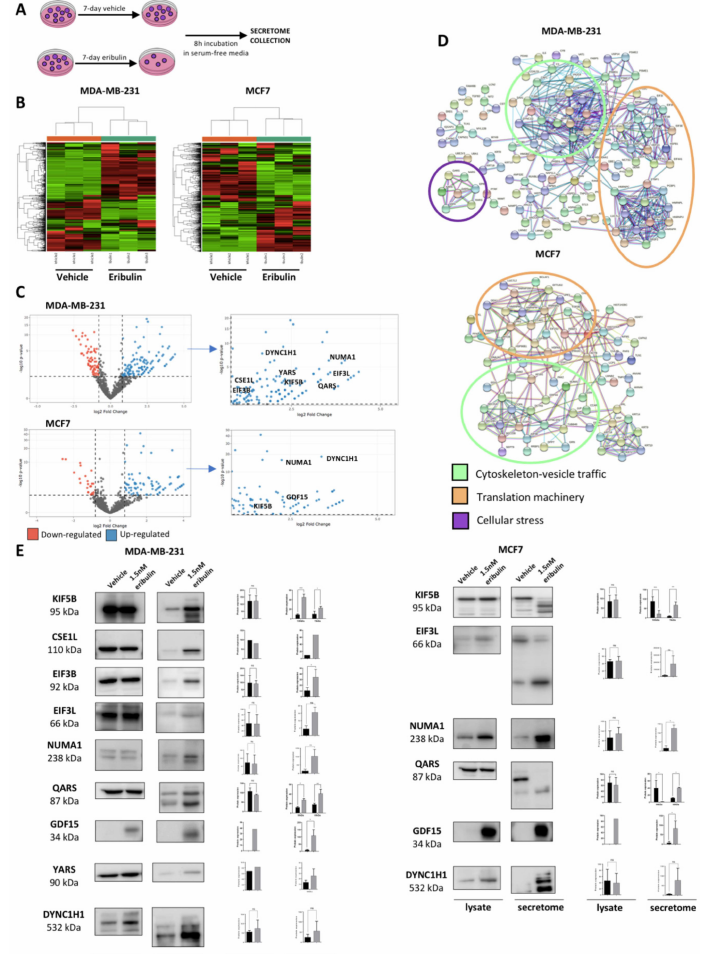
Figure 2. The secretome profiling of DTP cells reveals an over-secretion of a specific subfamily of biomarkers. ( A ) Schematic representation of secretome collection after a vehicle and eribulin treatment. ( B ) Heat maps representing the proteins that were significantly over-and/or down secreted, when MDA-MB-231 and MCF7 cells were treated for 7 days with vehicle or IC80 eribulin (representative heat maps of one out of three biological replicates showed in Supplemental data). Columns represent samples (per group); rows are m/z peaks (not in numerical order). ( C ) Volcano plots of the up-regulated (blue) and down-regulated (red) proteins after 7-day IC80 eribulin treatment. For each plot, the x -axis represents the log two-fold change (FC), and the y -axis represents -log 10 p -value. To identify statistically significant differentially secreted proteins, a Poisson statistical test was used to model our spectral count dataset. Adjusted p -value < 0.05, fold change > 0.8 and number spectral counts (SpC) > 4 thresholds were applied during the analysis. Enlargement of the up-regulated protein panel in the Volcano plot shows the eribulin induced secreted candidate biomarkers according to the protein subfamilies resulting from the STRING analysis (right panel). ( D ) STRING Network Analysis of over-secreted proteins after 7-day IC80 eribulin treatment showed two specific interaction nodes related to cytoskeleton-vesicle trafficking (green) and translation machinery (orange) protein subfamily. ( E ) Cell lysates (10 µ g) and secretome (10 µ g) were resolved by SDSPAGE and Western blotted against the different candidate biomarkers to confirm proteomic data. The figure shows a representative Western blot and the relative quantification from three biological replicates. * p -value < 0.05, ** p -value < 0.01, *** p -value < 0.001. GDF15 protein did not pass the established thresholds in the analysis for the MDA-MB-231 cell line, but nevertheless, Western blot analysis confirmed its secretion in this